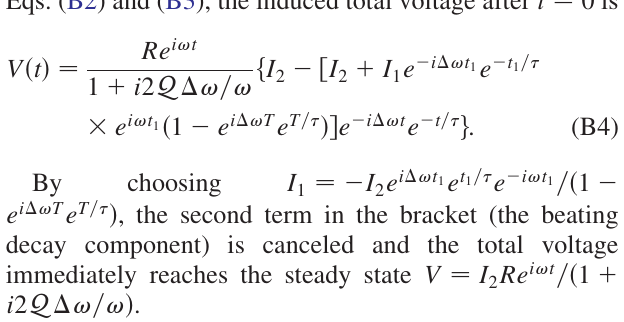
FIG. 14. (Color) Phase shift method. (a) Current profile. (b) The reduced filling time by cancellation of the two beating transients. The cyan curve is the voltage induced by the first step-pulse, the purple curve is induced by the second one, the red curve is the final voltage by summing two beating transients, and the green curve is the standard filling time curve for a single step pulse.